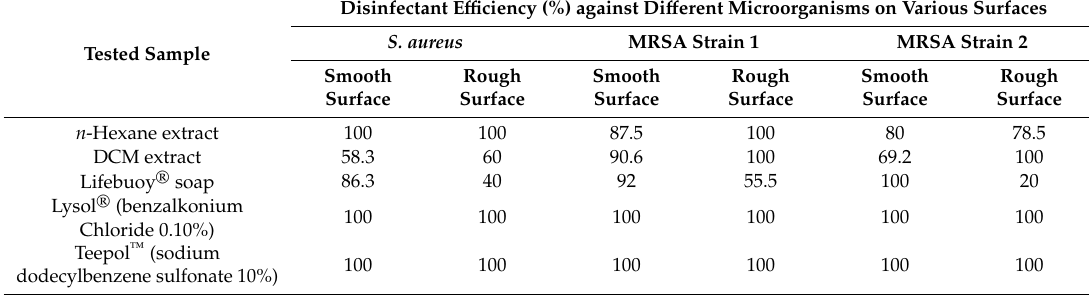
Table 4. Disinfectant potency of n -hexane and DCM extracts prepared from G. cambogia against S. aureus and MRSA strains. Data are given as means, n =